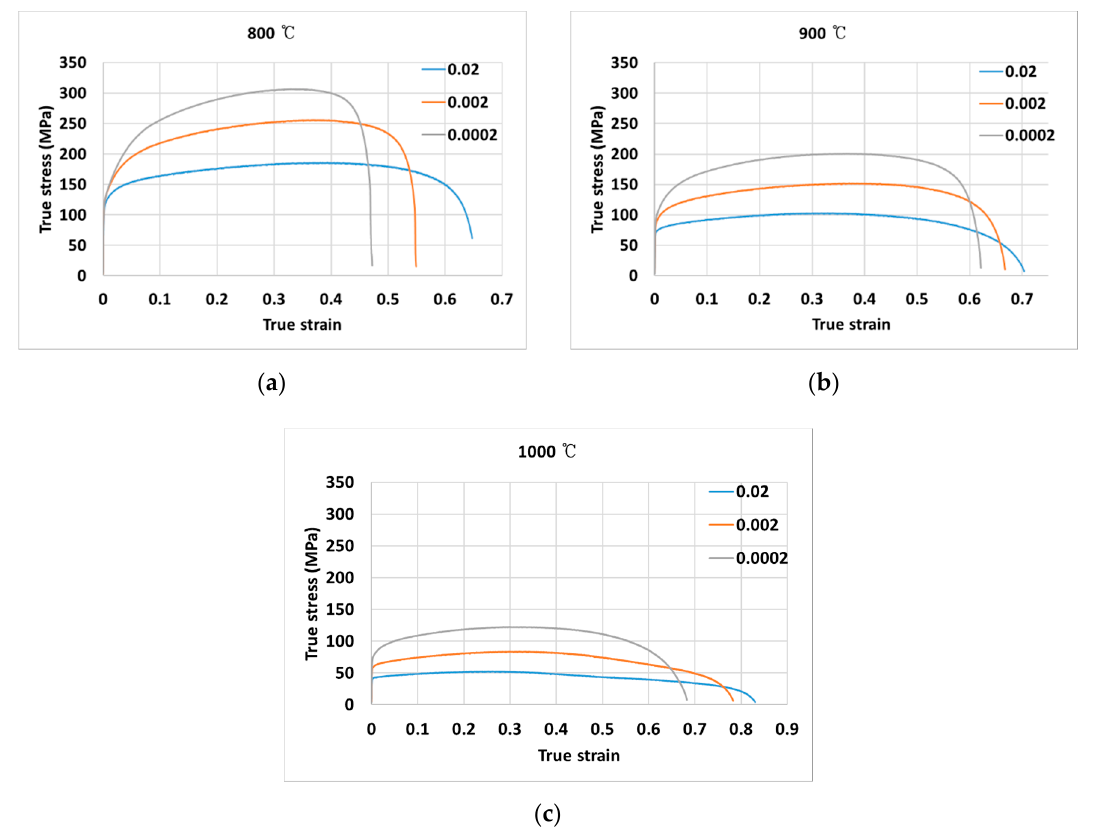
Figure 3. True stress-true strain curves at ( a ) 800 °C, ( b ) 900 °C, ( c ) 1000 °C.